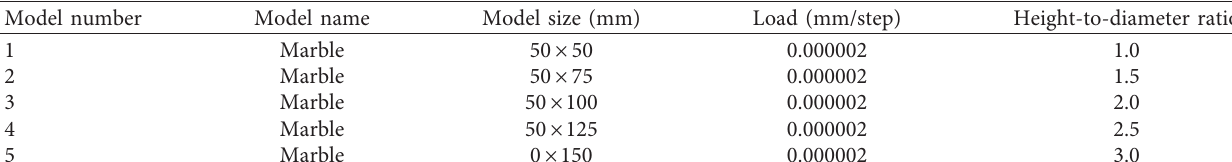
Table 3: Size effect model information.